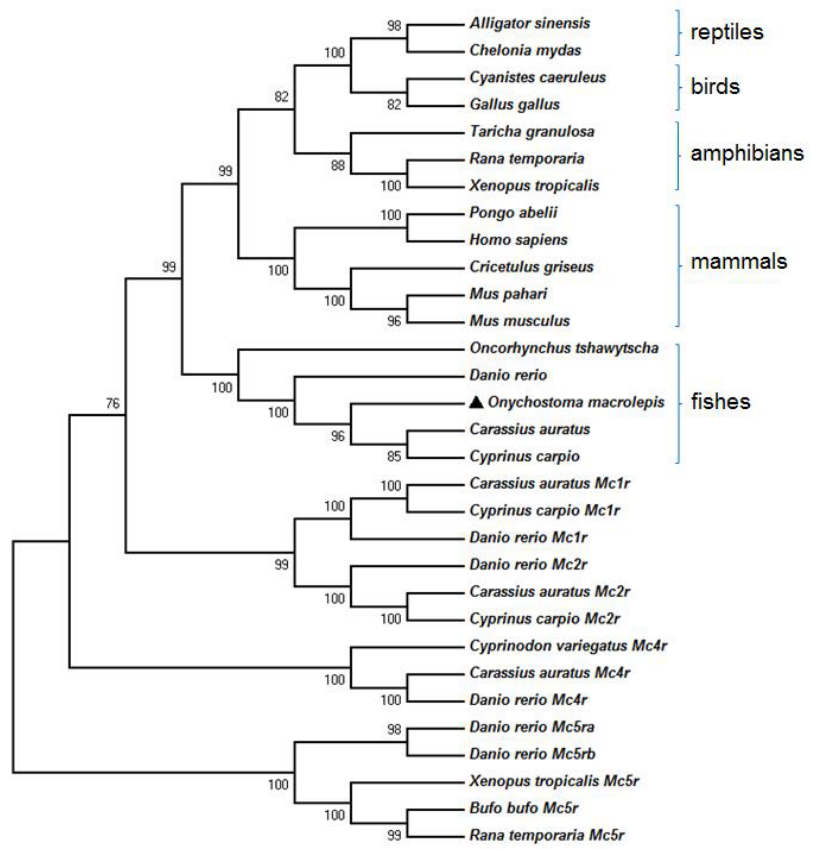
Figure 3. Phylogenetic tree of MC3Rs constructed by the neighbor-joining (NJ) method with MEGA X. The numbers under the nodes represent the bootstrap percentage values from 1000 replicates. The non-Mc3r paralogs together serve as the outgroups. The black triangle indicates omMc3r.